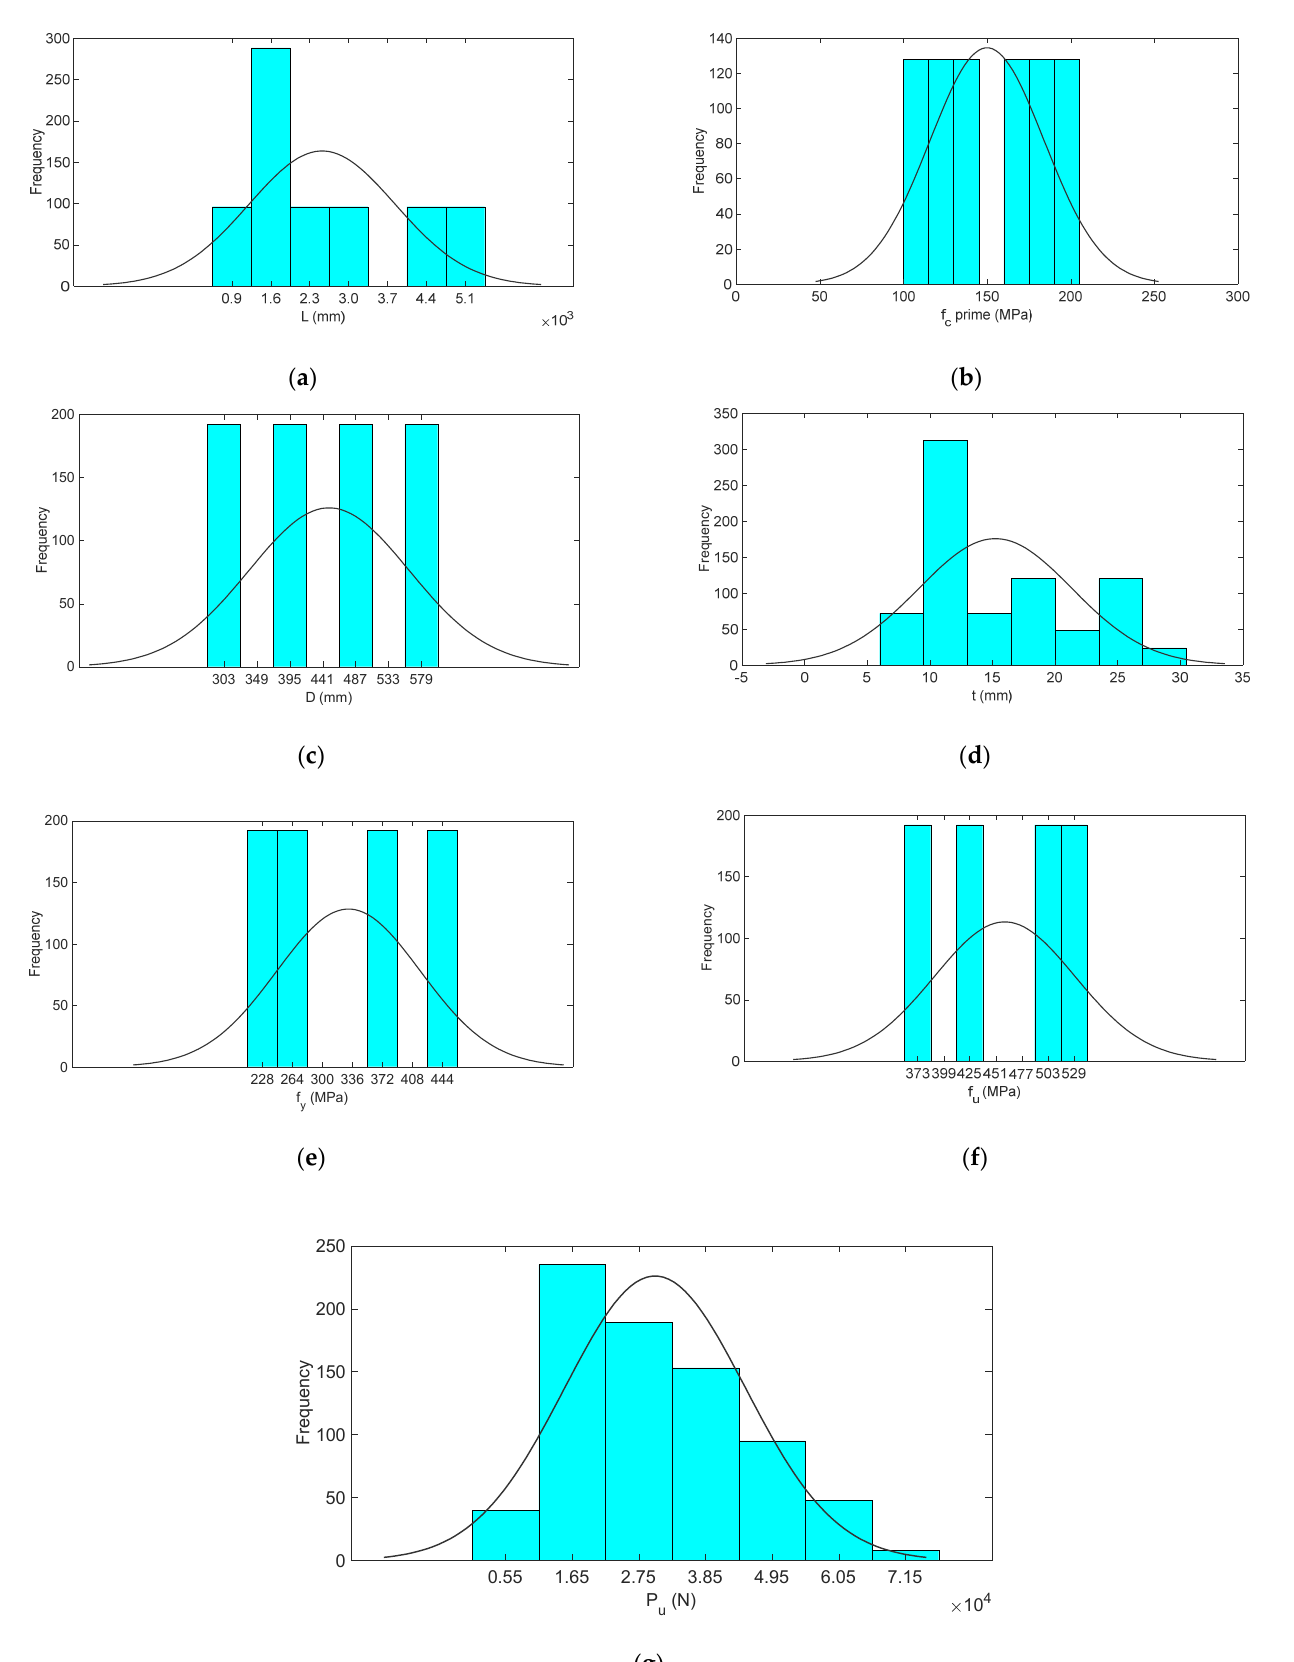
Figure 1. The frequency analysis of the input and target values.